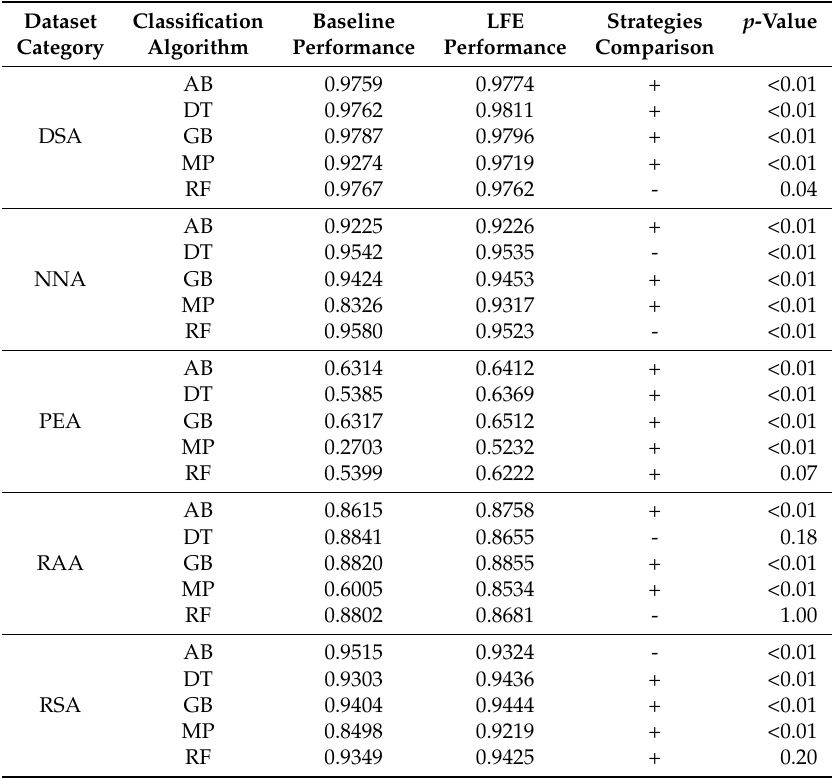
Table 12. NSL-KDD dataset—-LFE strategy performance